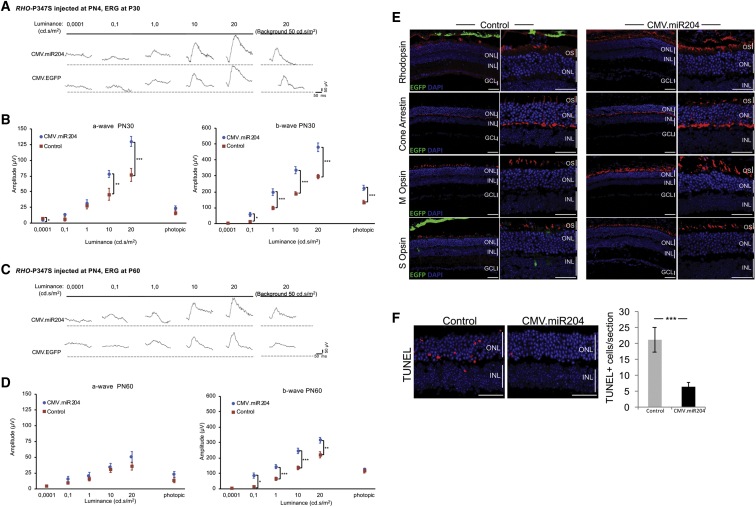
AAV-Mediated Delivery of miR-204 at PN4 Improves ERG Responses and Increases Photoreceptor Survival in RHO-P347S Mice(A and C) ERG traces measured at PN30 (A) and PN60 (C) at increasing luminance (cd⋅s/m2) from a representative mouse injected with the AAV.CMV.miR204 vector mix (i.e., 1 × 109 GC AAV.CMV.miR204, 1 × 108 GC AAV.CMV.EGFP) in one eye and the control vector mix (either 1.1 × 109 GC AAV.CMV.EGFP or 1 × 109 GC AAV.CMV.miR204MUT, 1 × 108 GC AAV.CMV.EGFP) in the contralateral one. (B and D) ERG responses of RHO-P347S mice injected with AAV.CMV.miR204 (n = 21) and the control vectors (i.e., AAV.CMV.EGFP or AAV.CMV.miR204MUT, AAV.CMV.EGFP) (n = 22) at PN4. ERGs were recorded at PN30 (B) and PN60 (D). Subretinal injection of AAV.CMV.miR204 results in an improvement of retinal function, which persists up to at least 2 months. Statistical significance (unpaired Student’s t test against control vector) is indicated with asterisks (*p < 0.05,**p < 0.01, ***p < 0.001). As a reference, the mean amplitude values of uninjected wild-type animals at different luminance conditions are given. For the a-wave: 0.0001 cd⋅s/m2, 6.1 mV; 0.1 cd⋅s/m2, 52.8 mV; 1 cd⋅s/m2, 213.4 mV; 10 cd⋅s/m2, 341.3 mV; 20 cd⋅s/m2, 401.1 mV; photopic, 26.4 mV. For the b-wave: 0.0001 cd⋅s/m2, 2.3 mV; 0.1 cd⋅s/m2, 315.8 mV; 1 cd⋅s/m2, 506.3 mV; 10 cd⋅s/m2, 732 mV; 20 cd⋅s/m2, 876.8 mV; photopic, 188.1 mV. (E) Confocal microscope images from immunolabeling for photoreceptor markers (Rhodopsin, Cone Arrestin, M Opsin, S Opsin; in red) on PN30 retinal sections. Nuclei were counterstained with DAPI (blue). Control virus delivery is visible by the EGFP fluorescence (green) and is more evident in the RPE of the control (AAV.CMV.EGFP)-treated eyes. For markers with polarized expression, comparisons were made between corresponding dorsal and ventral areas. Eyes injected with the CMV.miR204 vector show a stronger staining for PR markers, compared to the contralateral control-treated eyes. (F) Cell death analysis of TUNEL-stained retinal sections from eyes injected with the CMV.miR204 and the CMV.EGFP control vector. Quantification of TUNEL-positive photoreceptor nuclei per section (right) was performed on corresponding sections from serially sectioned, oriented eyes; n = 5 retinas. Error bars are SEM. Statistical significance (GLM analysis) is indicated with asterisks (***p < 0.001). GCL, ganglion cell layer; INL, inner nuclear layer; ONL, outer nuclear layer; OS, outer segments; RPE, retinal pigment epithelium. Scale bars: 50 μm.